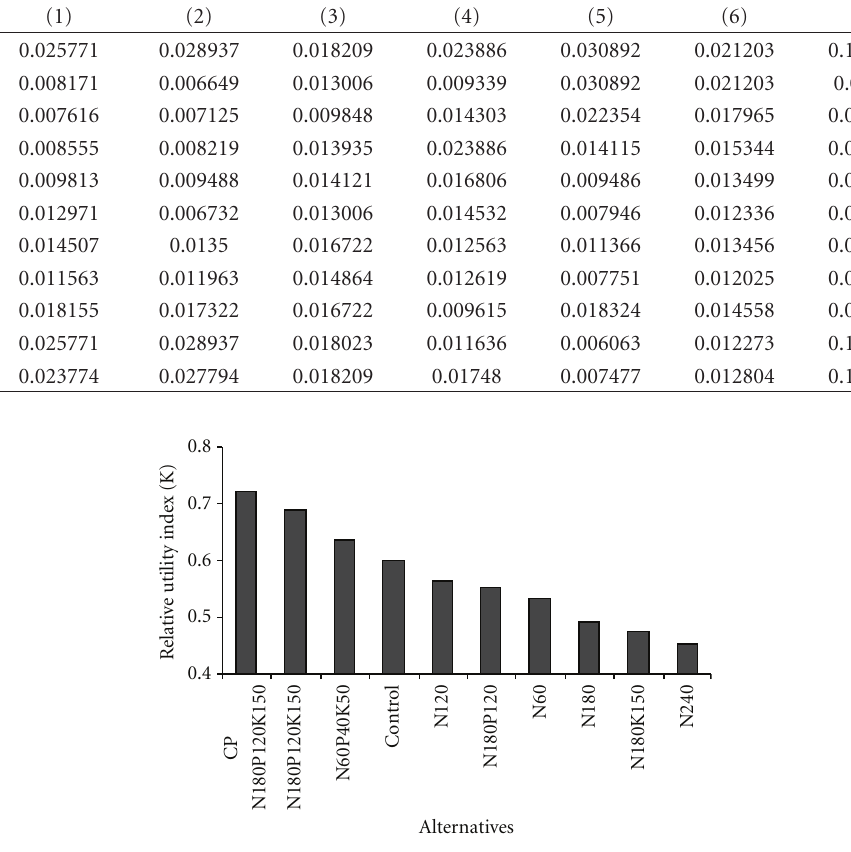
Figure 3: Relative utility of di ff erent treatments (comparison with the hypothetic ideal solution) in grassland agroecosystems.